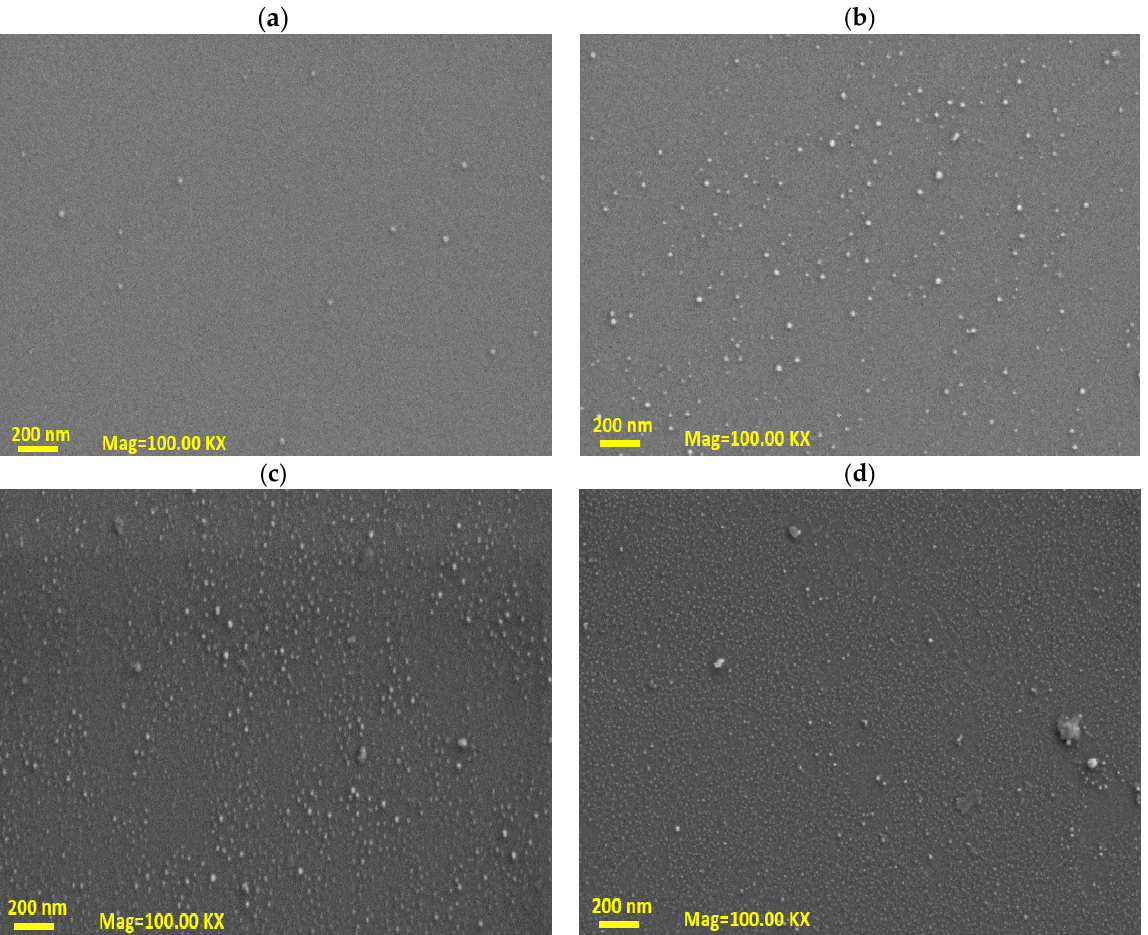
Figure 2. The FESEM of MoO 3 samples at 100 KX magnification: ( a ) S1, ( b ) S2, ( c ) S3, and ( d ) S4. We chose a high magnification scale of 100 KX for better resolutions of the ultrathin films as reported in this study.